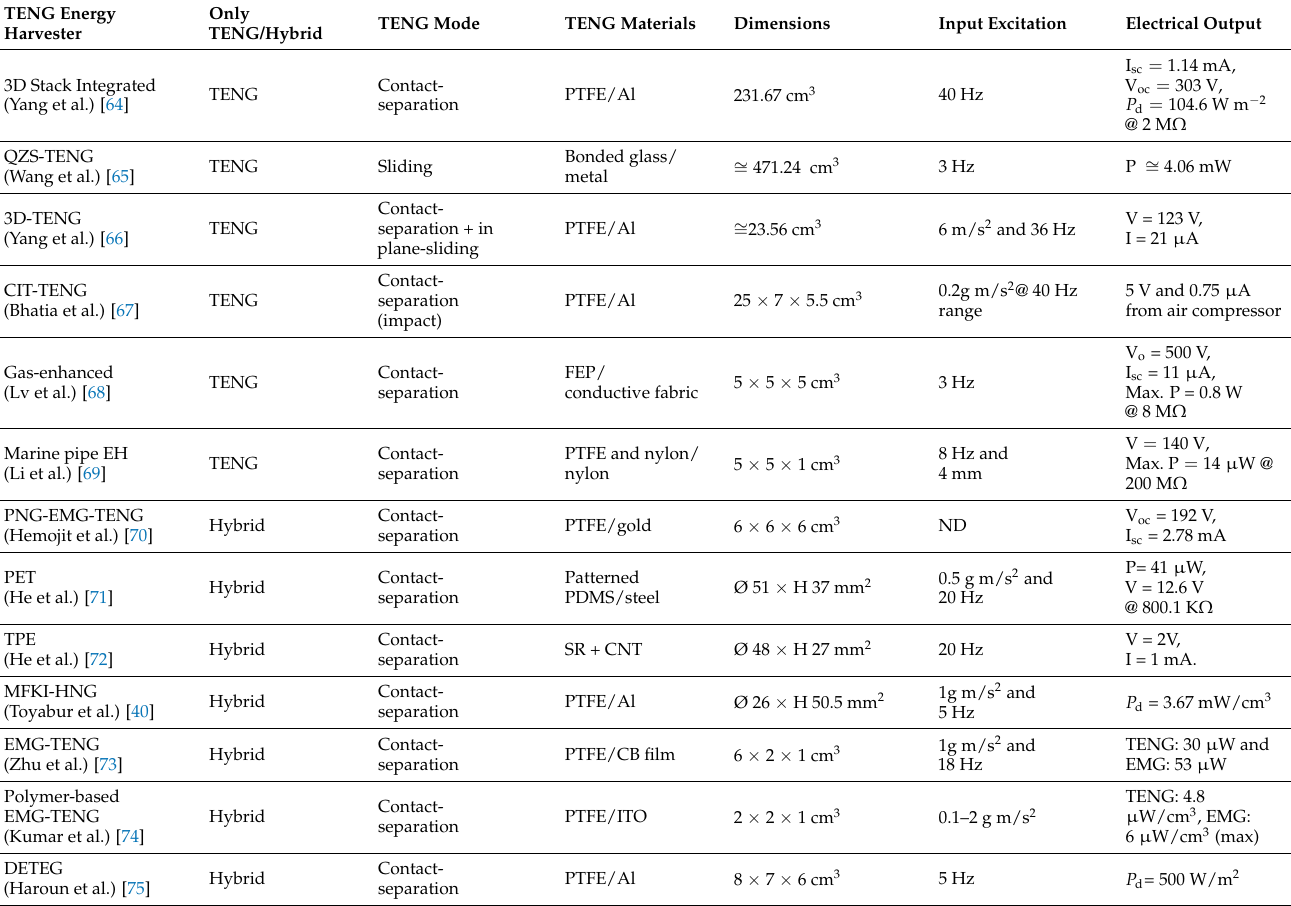
Table 1. Summary of the reviewed TENGs for vibration energy harvesting showing their main features, dimensions, and output